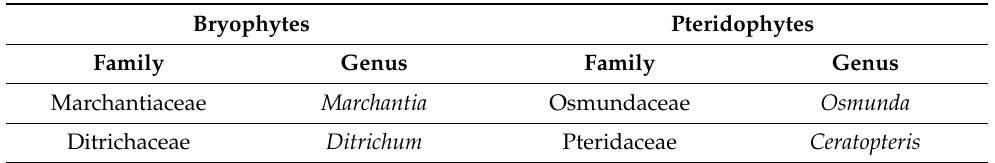
Table 9. Genera and families of bryophytes and pteridophytes captured in this literature search, representing cryopreservation work on these